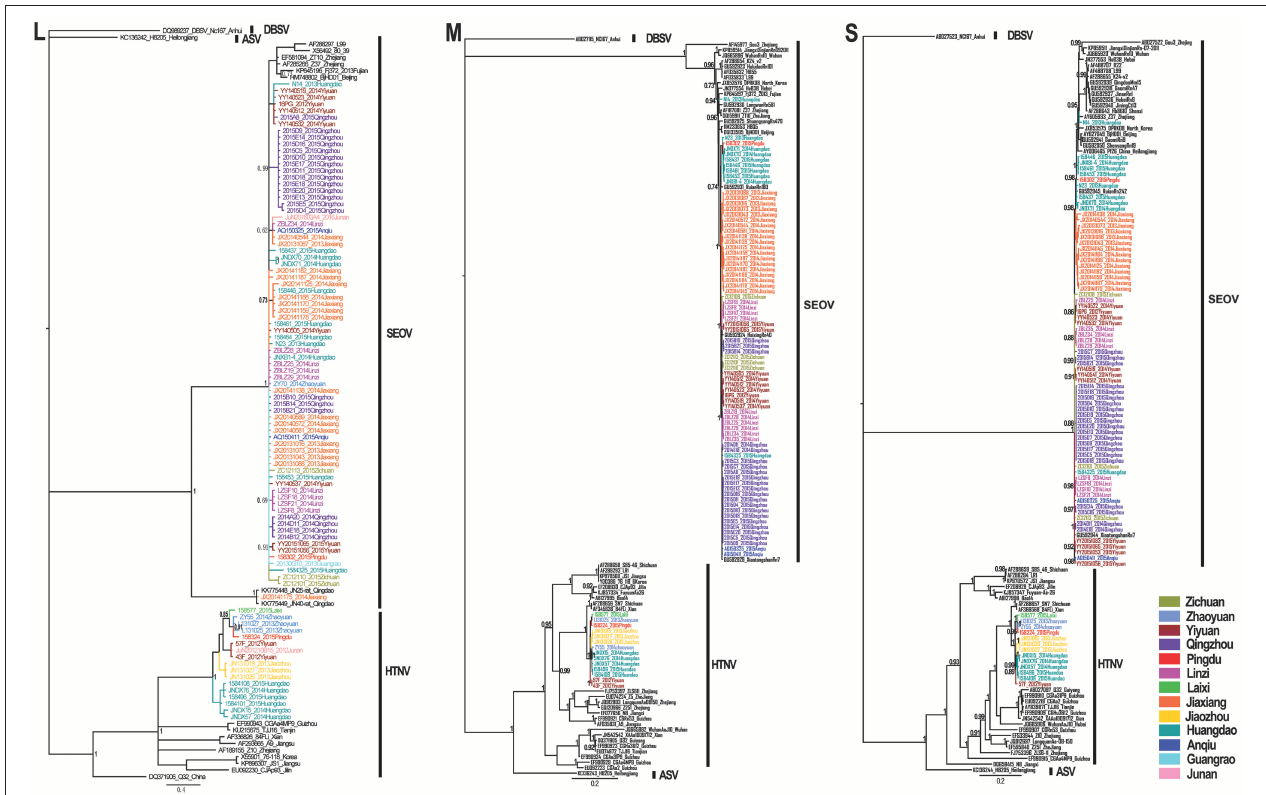
FIGURE 2 | Phylogenetic trees estimated by the Bayesian method using the MrBayes software based on the 329-nucleotide alignment of L-segment sequences, and ORF sequences of the M segment and S segment. Phylogenetic trees were constructed using the GTR evolutionary model, with Dabieshan virus NC167 strain as the outgroup, gamma-distributed rate variation across sites and a proportion of invariable sites. The run was stopped when the standard deviation of split frequencies reached below 0.01. The L (accession no. KY639712–KY639799), M (accession no. KY639536–KY639625), and S (accession no. KY639626–KY639711) sequences of hantaviruses obtained in this study are shown in different colors according to their geographic origin. The numbers at each node are posterior probabilities (PP) based on 6,000,000–12,000,000 trees. Only PP values > 0.6 are shown. The scale bar indicates the nucleotide substitutions per site. SEOV, Seoul virus; HTNV, Hantaan virus; DBSV, Dabieshan virus; ASV, Amur-Soochong